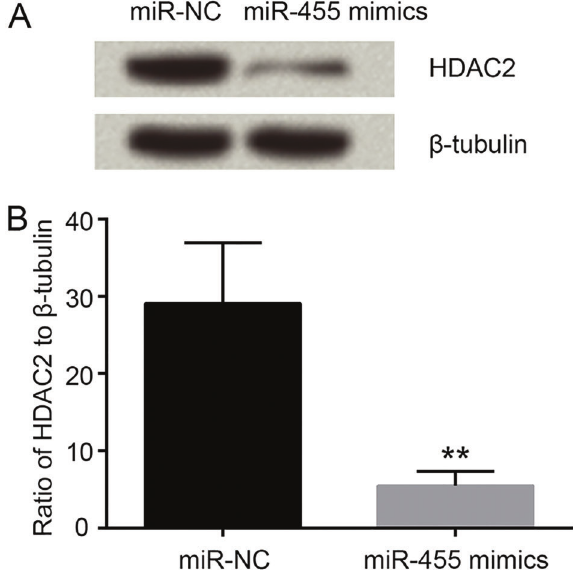
Figure 4. miR-455 reduced the expression of HDAC2. Data are reported as the mean ± SD of 3 independent experiments. **P o 0.01 (two-tailed unpaired t -test). HDAC2: histone deacetylase 2; miR-455 mimics: microRNA-455 mimics; miR-NC: negative control of